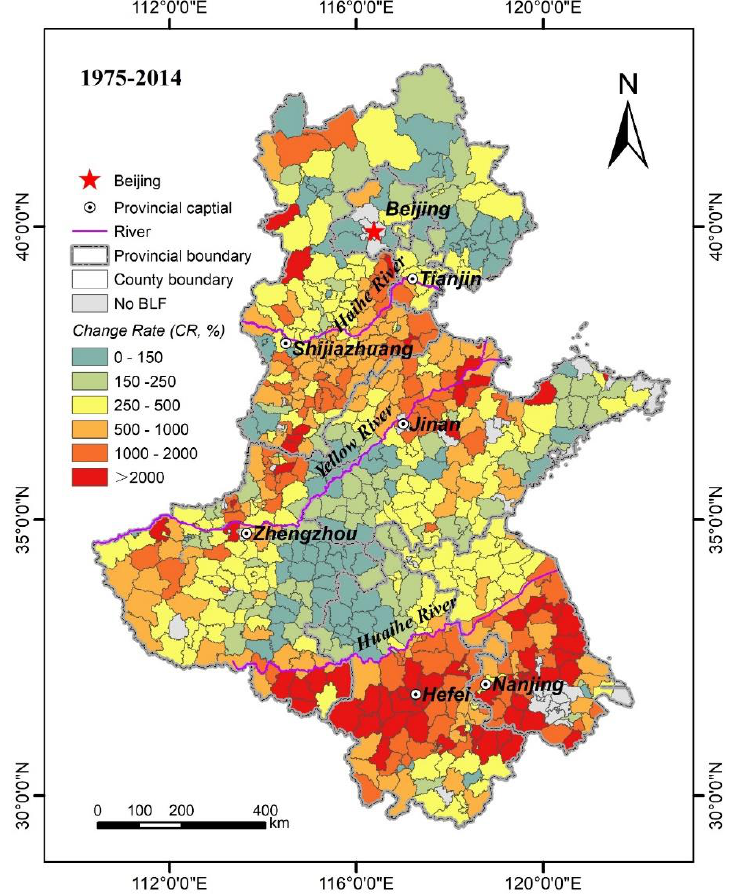
Figure 7. The change rate (CR) of the built-up land in floodplains of each county and district from 1975 to 2015. Table 2. The rapid growth of built-up land in floodplains from 1975 to